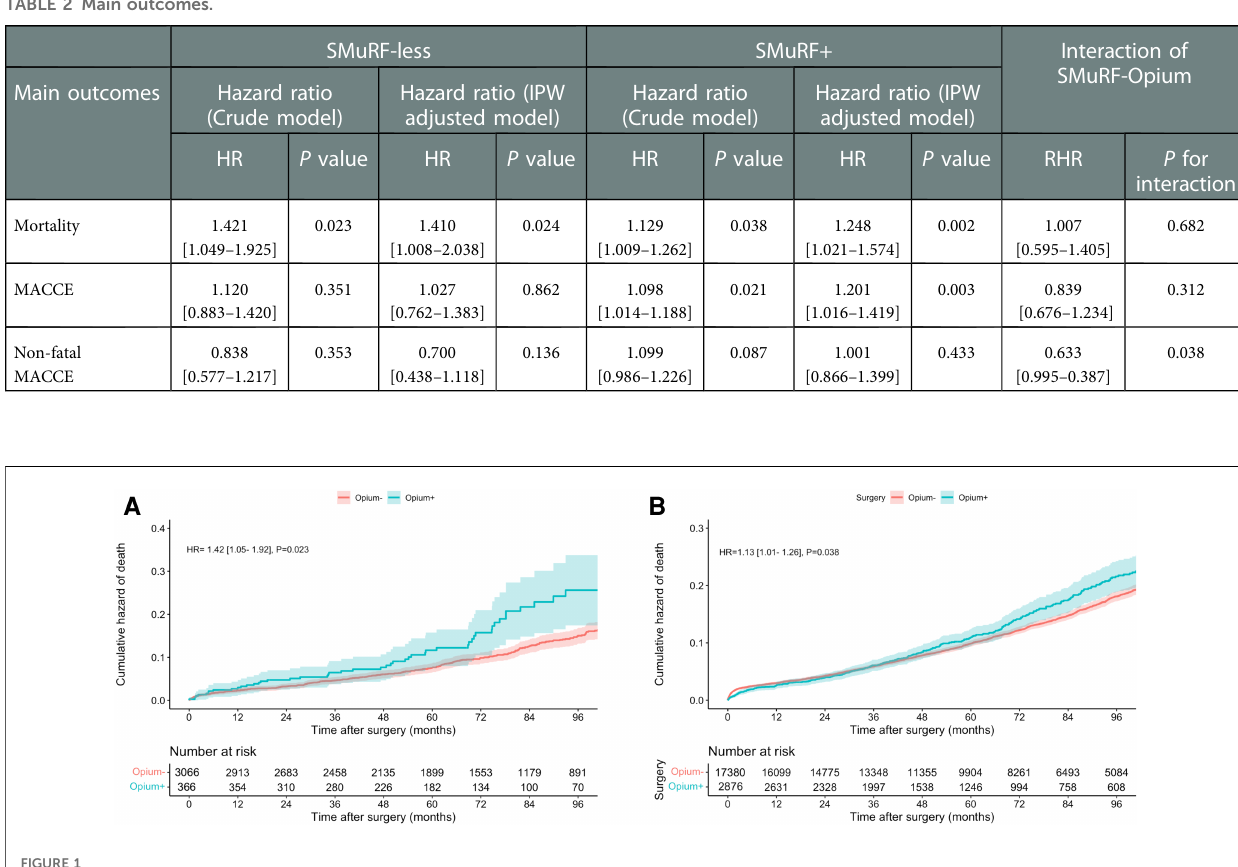
FIGURE 1 Cumulative hazard of mortality in patients without ( A ) and with ( B ) SMuRF.